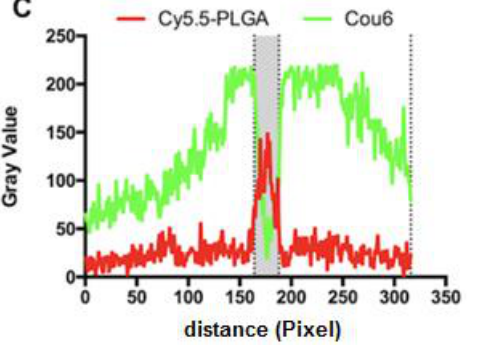
Figure 11. Biodistribution analysis of the intravenously injected Cy5.5-PLGA-Cou6 nanoparticles in rat retinal tissue. ( A )—signal of Cou6 as encapsulated dye and Cy5.5 as covalently linked dye observed by the ICON technique before intravenous injection (baseline; upper row) or post injection at 40 min (lower row); scale bar: 400 µ m. ( B )—background intensity of signal of Cou6 and Cy5.5 before intravenous injection at baseline. ( C )—intensity of signal of Cou6 and Cy5.5 40 min post injection. Area highlighted in gray in ( B ) and ( C ): blood vessel